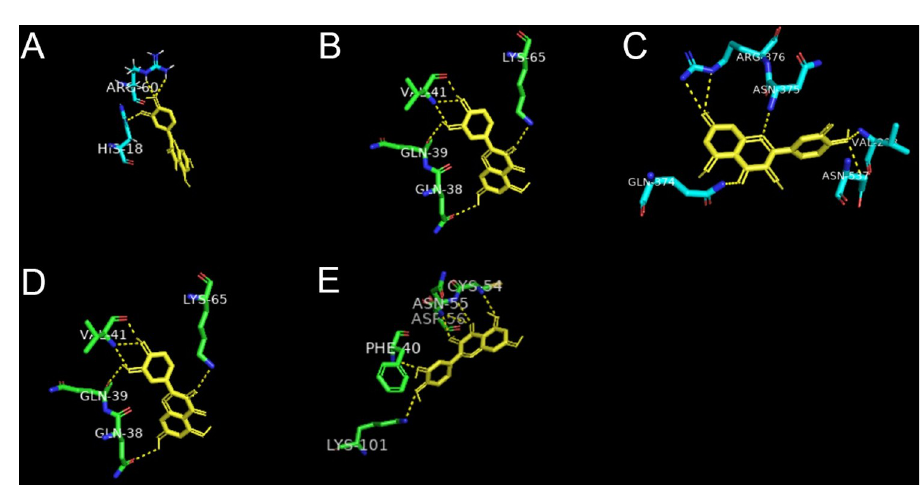
Fig 7. Molecular models of quercetin binding to its predicted protein targets. Proteins (A) CCL2 -3IFD, (B) CXCL8- 5WDZ, (C) PTGS2 -5F1A, (D) IL1B- 5I1B, and (E) VEGFA -3QTK interact with a quercetin molecule, and these interactions are represented by a yellow stick model. Lines represent residues in the binding sites. The yellow dashed lines represent hydrogen bonds. The abbreviation of amino acids and their positions on proteins are indicated next to the